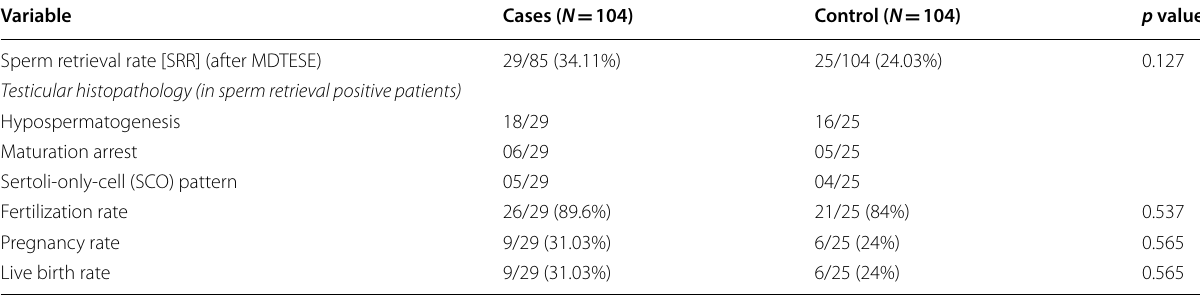
Table 2 Post-MDTESE results with comparison Variable Sperm retrieval rate [SRR] (after